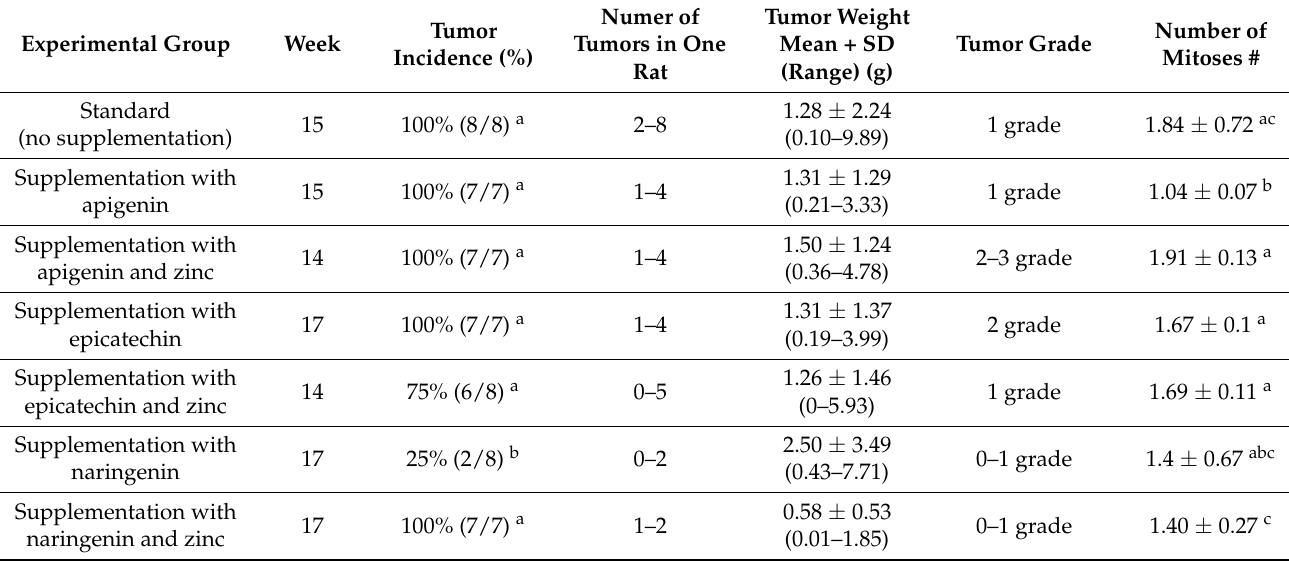
Table 1. Mammary tumor formation in individual experimental groups with 7,12-dimethylbenz[a]